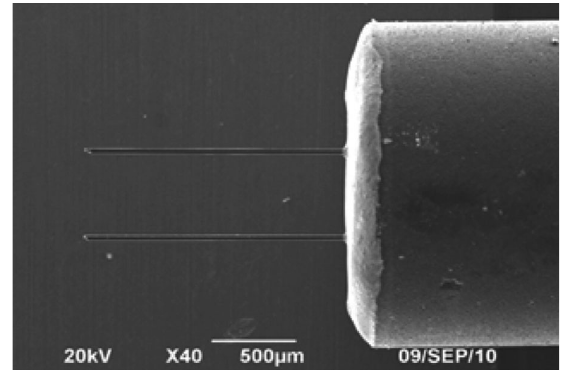
FIG. 1. Two single carbon fiber field emitters 35 μ m diameter and hundreds of μ m in